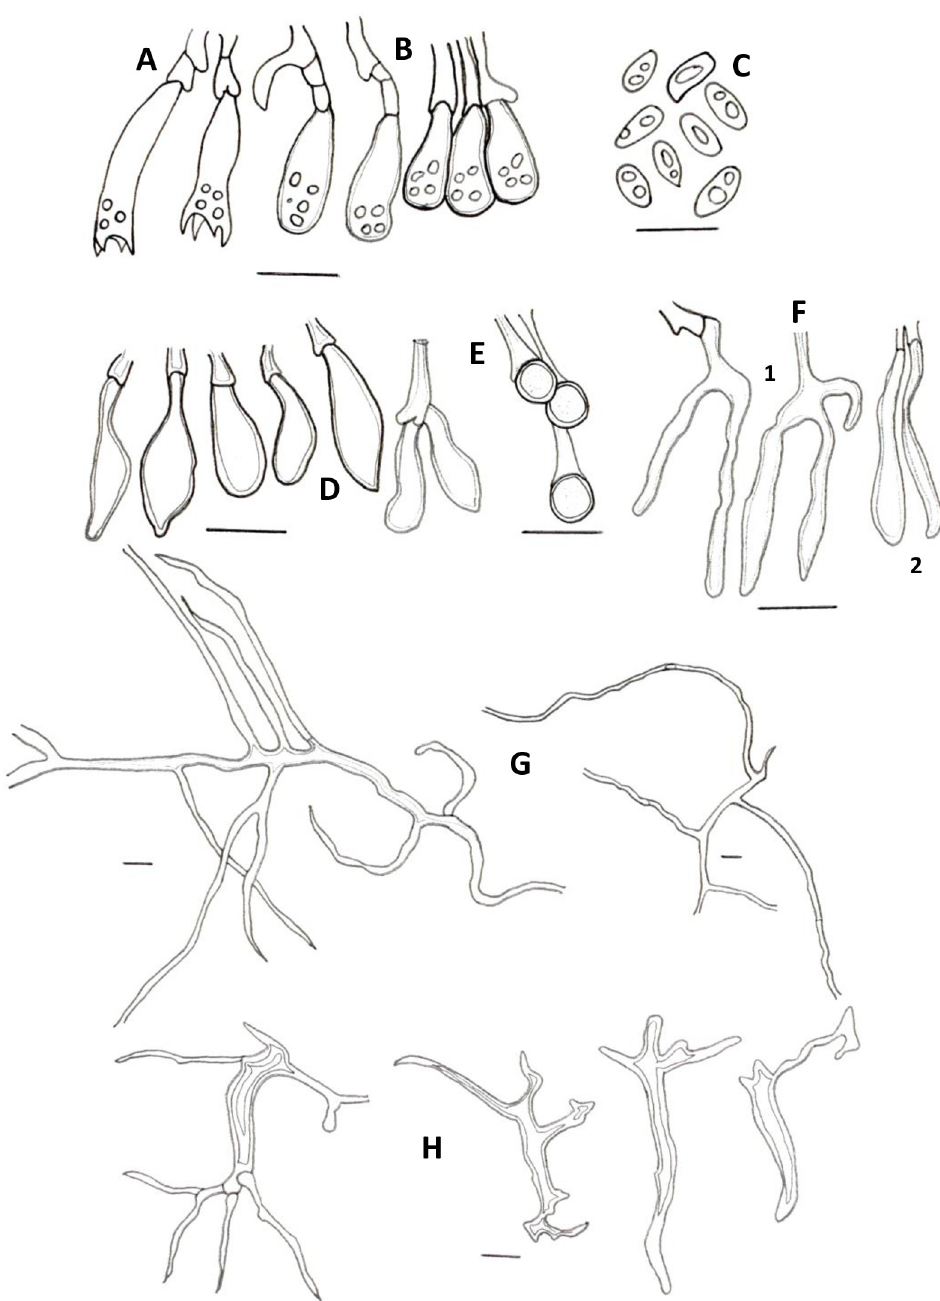
Fig 12. Microscopical features from trama of P . leprieurii var. yasuniensis . A. Basidia. B. Basidioles. C. Basidiospores. D-E. Cystidioles. D. Cystidioles of the ventricose. E. Thick-walled round-like cystidia cells. F. Hyphidia, 1. Dichohyphidia and 2. Tubular. G. Skeletal-binding hyphae. H. Thick-walled distinctive stalks of tramal hyphae. Scale bars = 10 μ